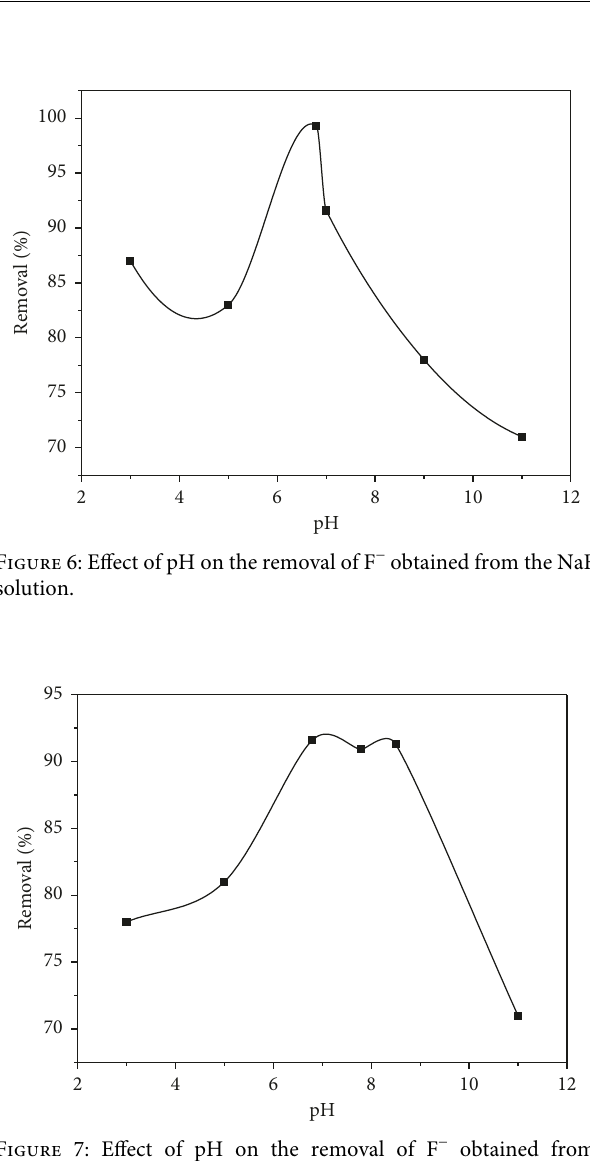
Table 2: The EDAX analysis results of GO nanostructure. Element